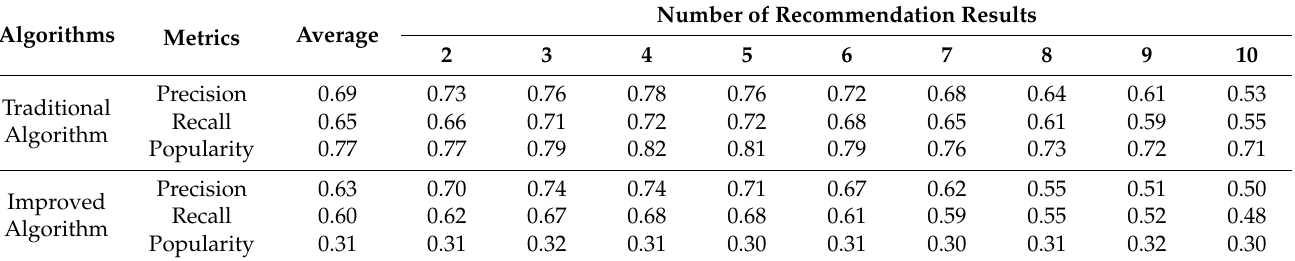
Table 5. Performance comparison between the improved recommendation algorithm and the tradi- tional recommendation